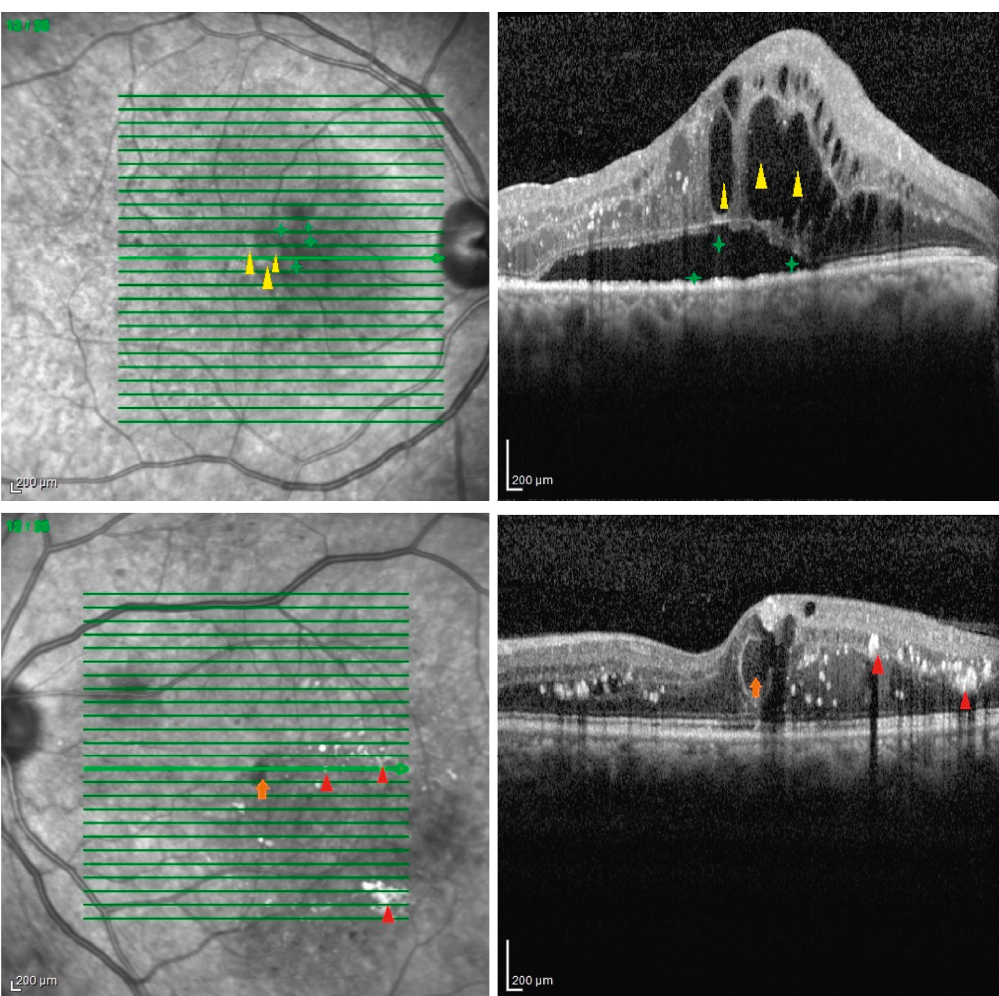
Figure 1: Near-infrared reflectance taken with OCT SLO image with related OCT image (left and right images, respectively) shows hyperreflectivity at the site of large cysts (yellow arrowhead) and hyporeflectivity at the site of subretinal fluid (green plus) in top row images. NIR also shows hyporeflectivity at the site of medium cyst (orange arrow) and hyperreflectivity at the site of exudates (red arrowhead) at bottom row images.